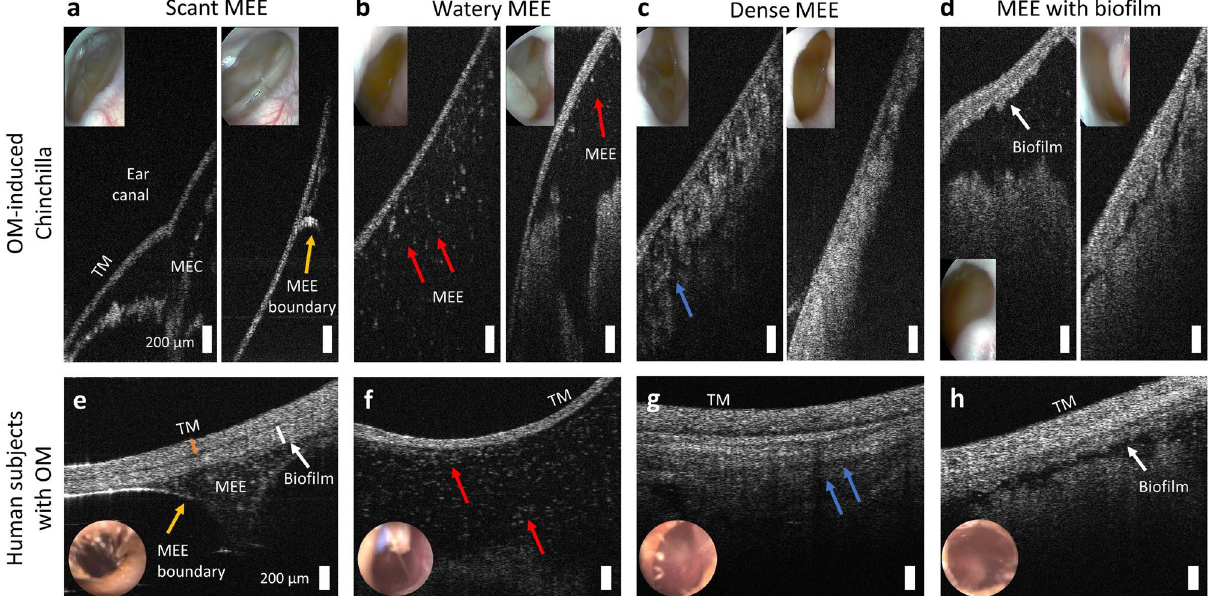
Figure 4. OCT images of different MEE representations in chinchilla compared with those in human subjects. ( a ) Retracted TM and the presence of a scant MEE. (b) Particulate-like scatterers present in transparent fluid. ( c ) A dense, highly scattering tissue-like (brighter OCT signals) MEE (blue arrows). ( d ) The presence of a TM biofilm as well as dense biomass. Images were acquired from different chinchillas. ( e ) OCT image of a scant MEE and biofilm from a 3-year-old human subject diagnosed with bilateral recurrent acute suppurative OM. Inset figures represent the otoscope surface view of the TM. ( f ) OCT and otoscope images of a fully filled watery MEE from a 2-year-old subject diagnosed with chronic serous OM. ( g ) OCT and otoscope images from a 1-year-old subject diagnosed with recurrent acute OM. ( h ) OCT and otoscope images of biofilm and MEE from a 14-month-old subject diagnosed with recurrent acute OM. All scale bars represent 200